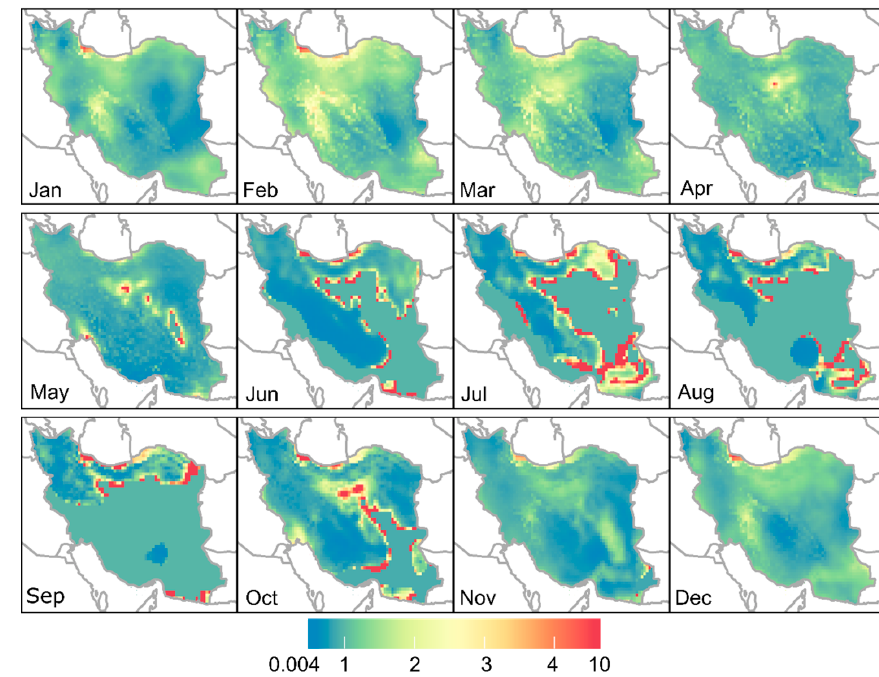
Figure 3. Ratios of monthly observed precipitation to Princeton from 1988 to 2012. (Three grid cells have ratios higher than 10 from June to October and they are not marked in the legend in the figure.). The delta values of monthly maximum and minimum temperatures from Princeton to OBS at station points from 1988 to 2012 are presented in Figures 4 and 5, respectively. For monthly maximum temperature, the delta values ranged from − 14 °C to 13 °C, with an average of 0.2 °C. The coastal areas near the Caspian Sea and northwestern part have higher absolute delta values than the other areas, in general. The delta values for monthly minimum temperatures ranged from − 10 °C to 15 °C, with an average value of 1.4 °C. From October to April, most station points in the northwestern part of Iran showed delta values of higher than 4 °C, meaning that the PGF datasets have underestimated minimum temperatures in these months. We then applied the monthly delta values to the daily maximum and minimum temperatures of the PGF dataset.